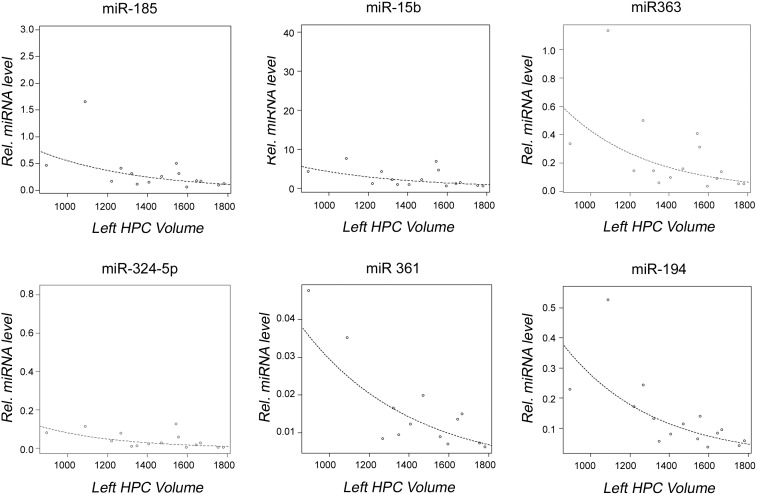
Observed correlation between dysregulated miRNAs and left hippocampal volume.Graphs showing a correlation between miRNA expression levels and left hippocampal volume within the 22q11DS group. Open circles represent individuals with 22q11DS; the line represents line of best fit. P-values given are for correlations.